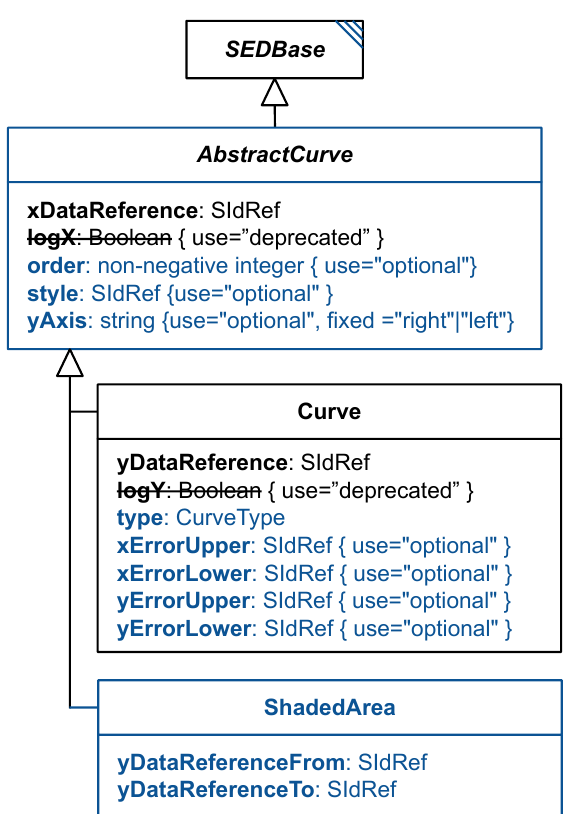
Figure 2.22: The definition of the SED-ML AbstractCurve , Curve, and ShadedArea